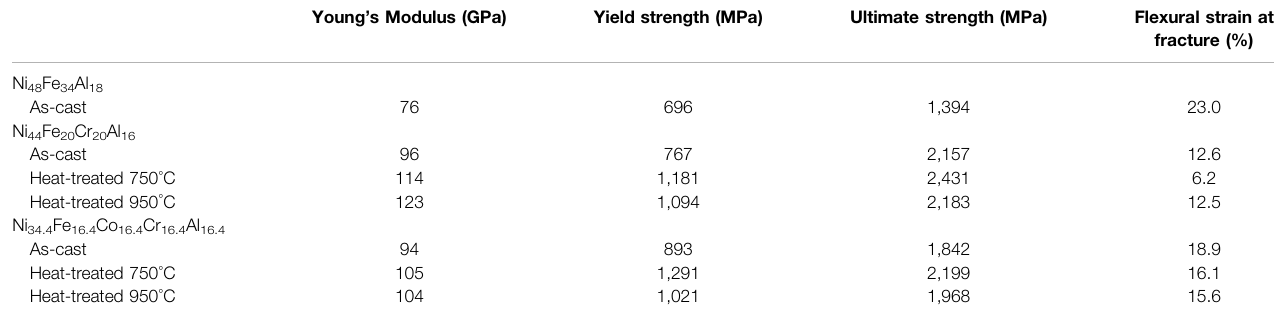
TABLE 5 | Summary of the mechanical data as obtained from three point bending experiments conducted on various bar samples of the three alloys. Young ’ s Modulus (GPa) Yield strength (MPa) Ultimate strength (MPa) Flexural strain at